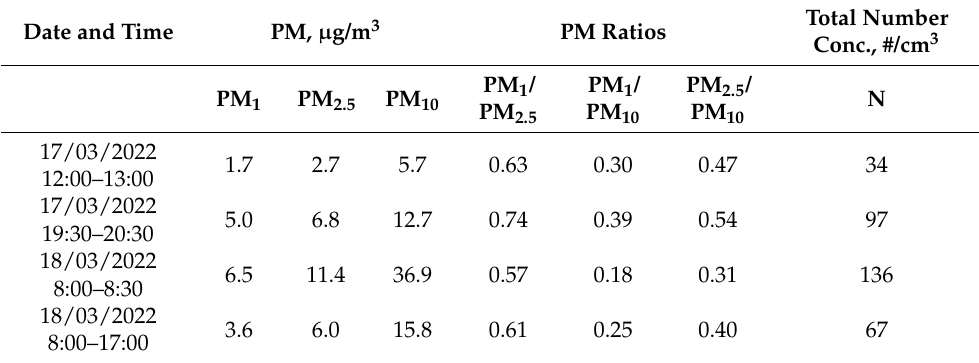
Table 2. PM mass and number concentrations station and PM ratios during field experiment at the urban